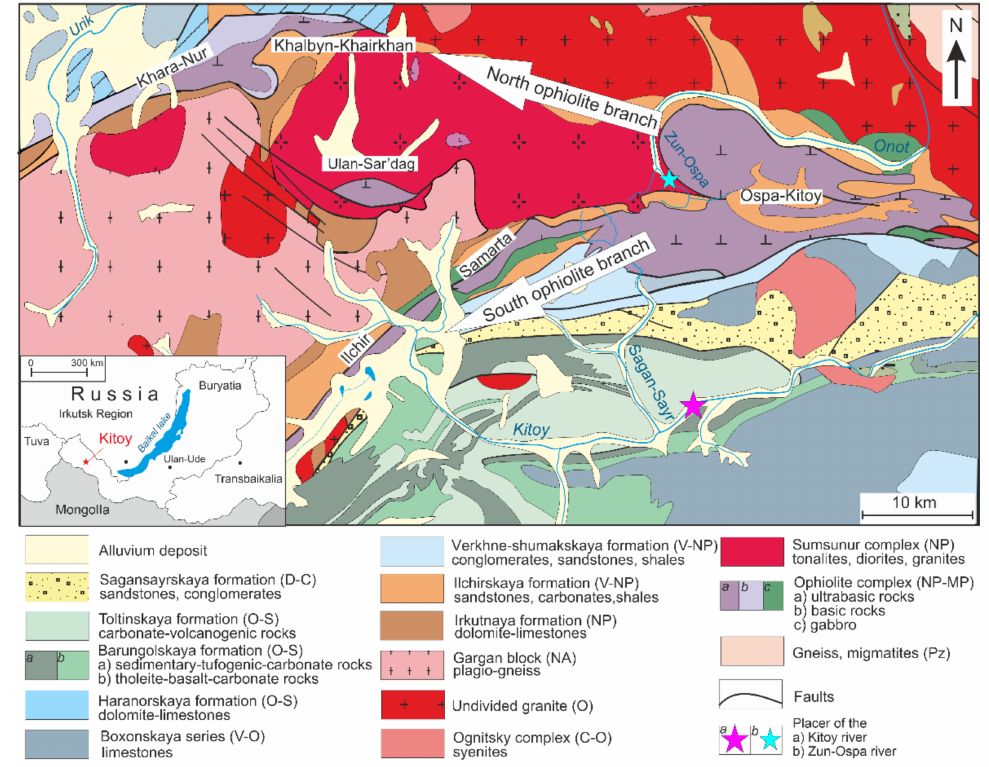
Figure 1. Geological map of the southeastern part of the Eastern Sayan region